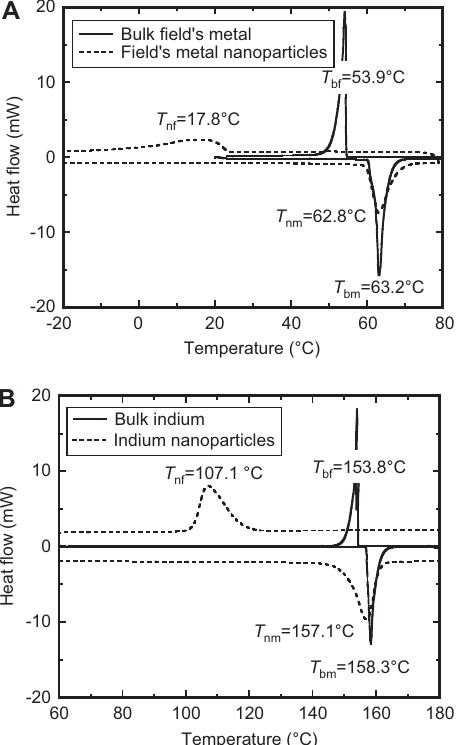
Figure 18 The DSC heating and cooling curves for the as-prepared (A) Field ’ s metal and (B) the indium nanoparticles dispersed in the PAO oil. For comparison, the experimental data for the correspond- ing bulk metals are also plotted. The melting-freezing phase transi- tion points correspond to the endothermal and exothermal peaks. The subscripts are as follows: b, bulk metal; n, nanoparticles; m, melting; f,